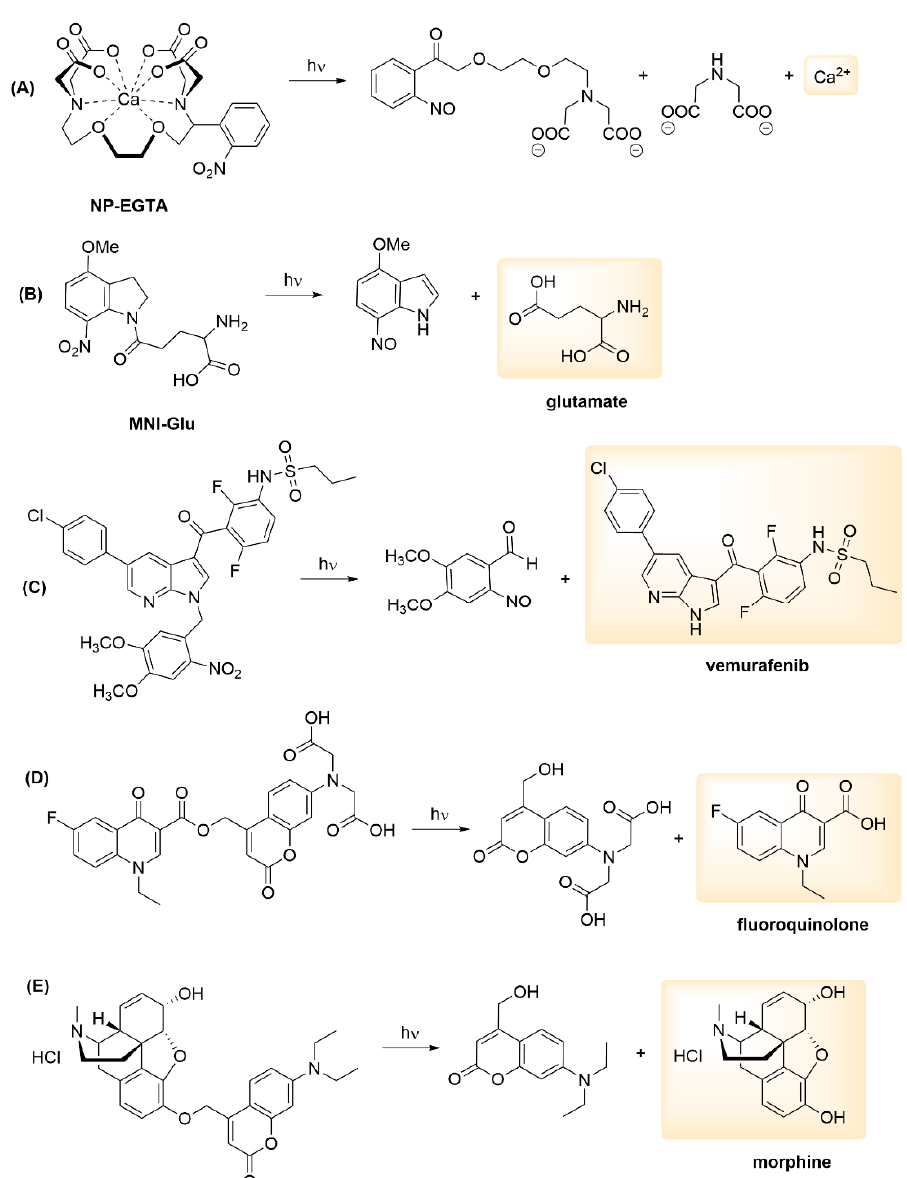
Figure 3. Examples of PPG applications for small molecules/inorganic species: ( A ) calcium caging with photoactivatable EGTA [32], ( B ) neurotransmitter glutamate caging with MNI [21], ( C ) caging the anticancer agent vemurafenib with a nitrobenzyl PPG [33], ( D ) a coumarin PPG-caged antibiotic agent [34], ( E ) a coumarin PPG-caged analgesic [27].